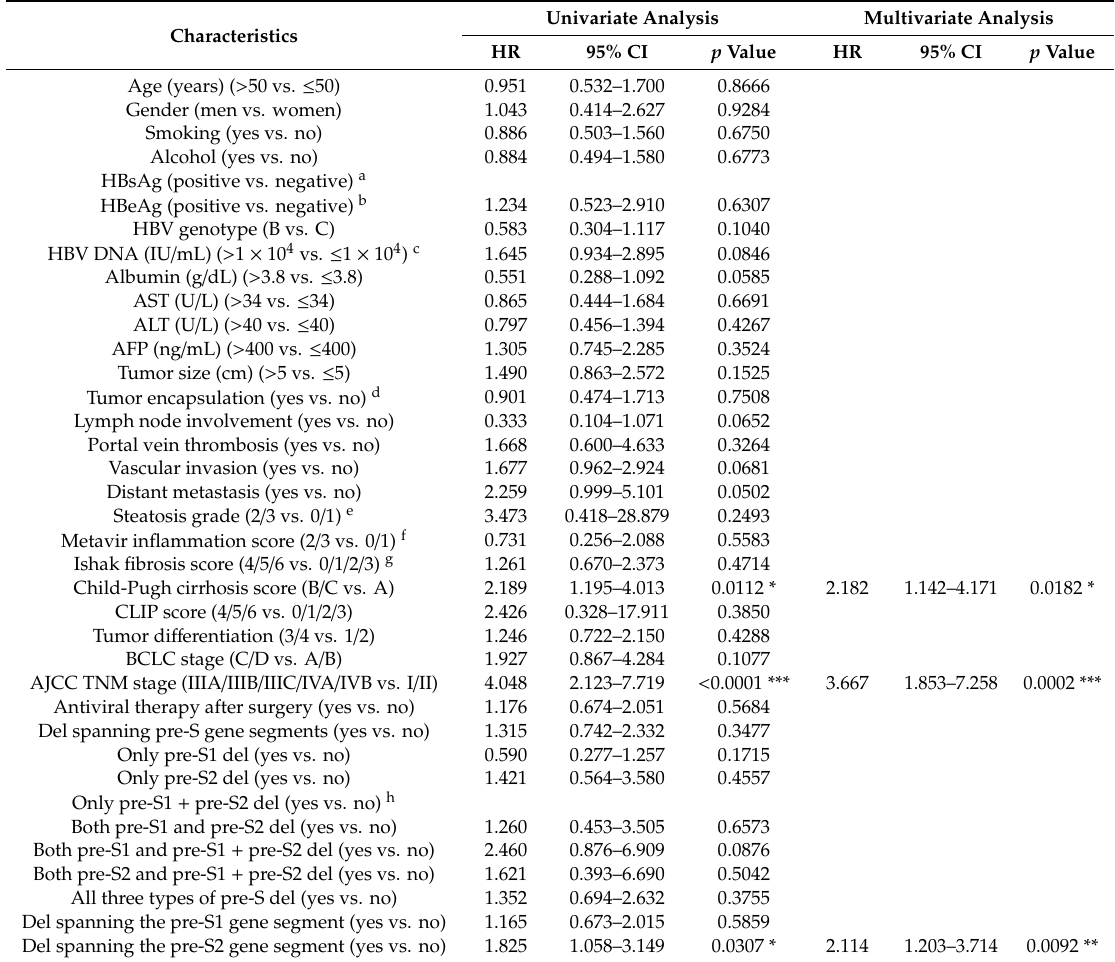
Table 3. Univariate and multivariate analyses of pre-S deletion type for recurrence-free survival in 75 HBV-related HCC patients.